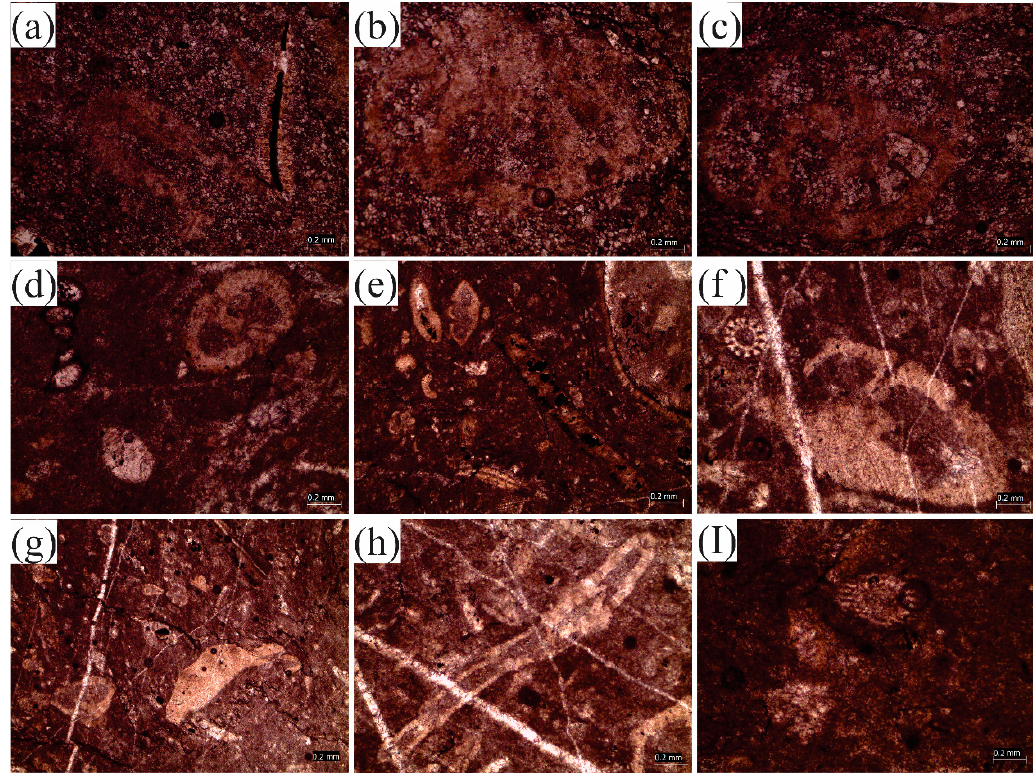
Figure 5. Photomicrographs showing ( a ) Discocyclina spp. on the right and Fabiania spp. on the left; ( b ) Lockhartia spp.; ( c ) Rotalia trochidiformis ; ( d ) Acervulinidae spp. on the left and Rotalia trochodiformis on the right; ( e ) Distichoplax biserialis (coralline algae); ( f ) echinoid spine ( Echinothrix ); ( g ) Quinqueloculina granulocostata and calcified algae ( Vermiporella ); ( h ) Ranikothalia nuttalli ; and ( I ) spatangoid spine algae.